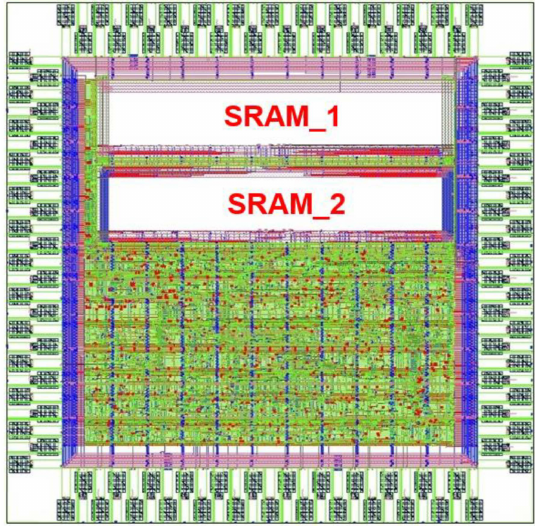
Figure 23. Chip layout of the proposed transformation and transmission bridge between the Ethernet Modbus TCP and USB 3.0.